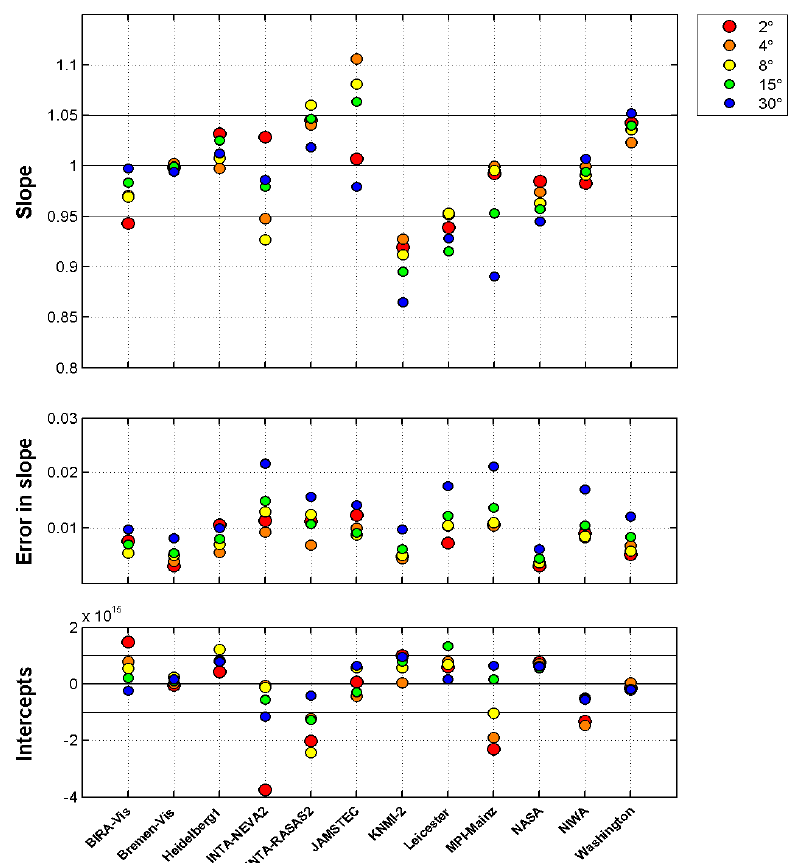
Fig. 6. Straight-line slopes and their standard errors of NO 2 slant columns against those of the reference data set, for each instrument at visible wavelengths and for the whole campaign. Colours refer to elevation angles shown top right. Note that MPI-Mainz used a non-standard wavelength range for spectral analysis because of the limited range of the instrument (see Table 1).